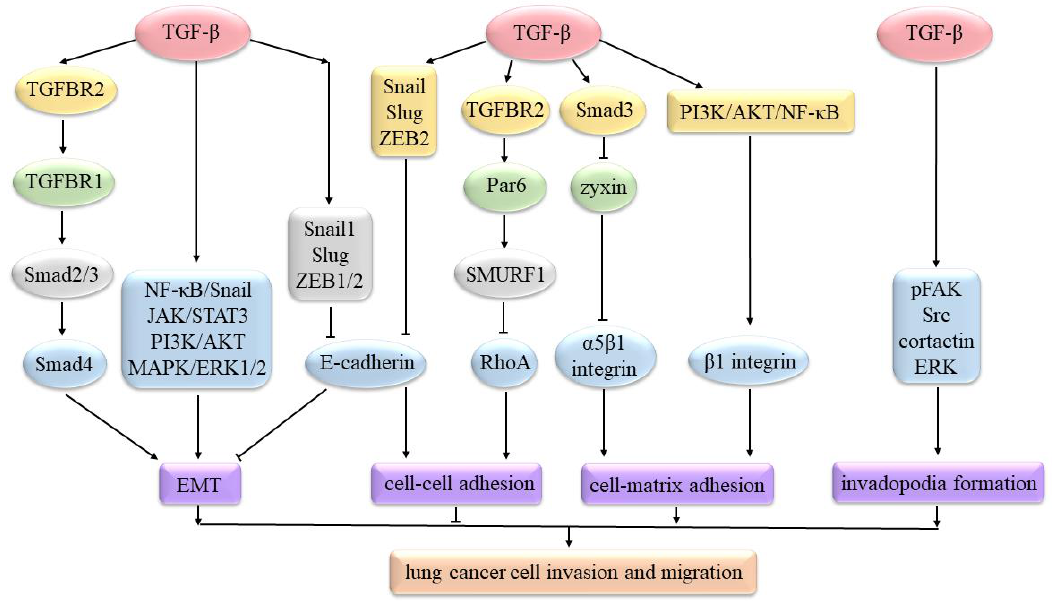
Figure 1. TGF- β signaling regulates lung cancer cell invasion and migration. TGF- β can mediate EMT via Smad pathways and non-Smad pathways. TGF- β can increase Snail, Slug, and ZEB2 expression to decrease E-cadherin. It can also bind to TGFBR2 and then phosphorylate Par6 to recruit Smad ubiquitin regulatory factor 1 (SMURF1). SMURF1 can degrade RhoA. These can reduce cell–cell adhesion. TGF- β 1 can activate PI3K / AKT / NF- κ B to increase β 1 integrin expression. TGF- β / Smad3 signal can increase α 5 β 1 integrin expression by down-regulating zyxin. These can enhance cell–matrix adhesion. TGF- β can increase phosphorylated focal adhesion kinase (pFAK), Src, cortactin, and ERK in response to β 3 integrin, resulting in forming a mature invadopodia.